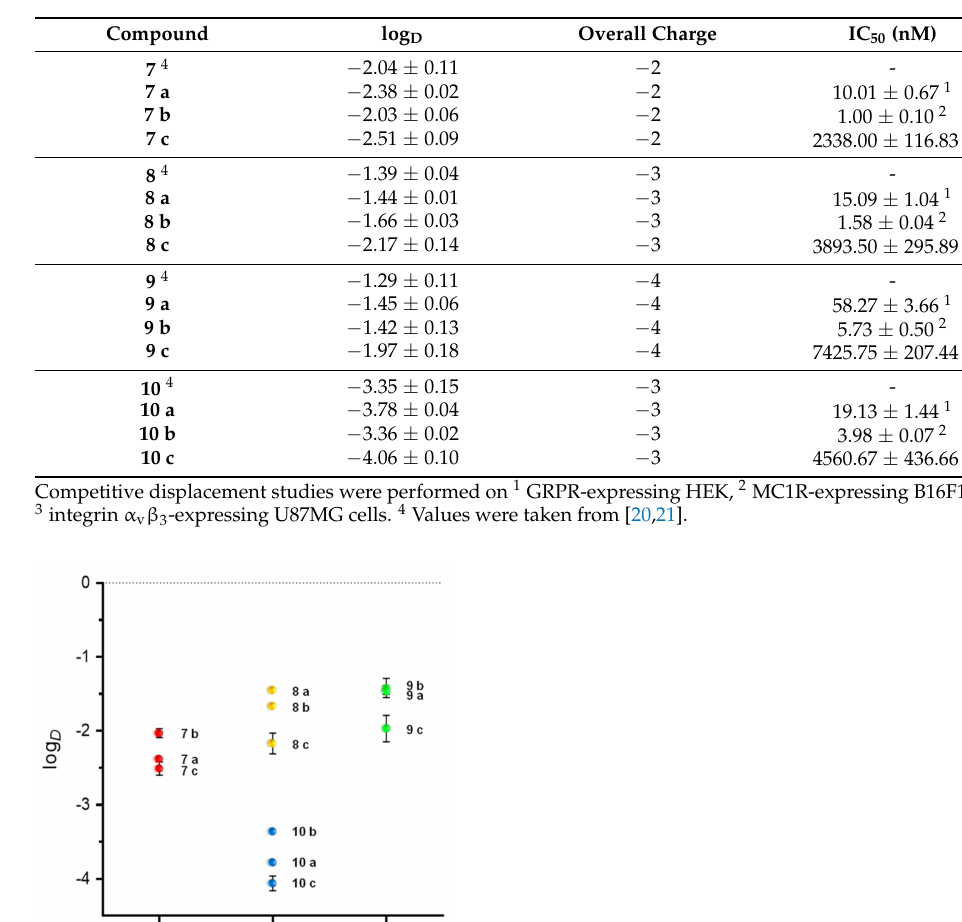
Table 3. Summary of the log D values of the MIUs 7 - 9 and the corresponding hybrid bioconjugates [ 68 Ga]Ga- 7 a-c , [ 68 Ga]Ga- 8 a-c , [ 68 Ga]Ga- 9 a-c and [ 68 Ga]Ga- 10 a-c as well as of the receptor affinity data (IC 50 values) measured on the respective cell lines. Values are given as mean ± SD.